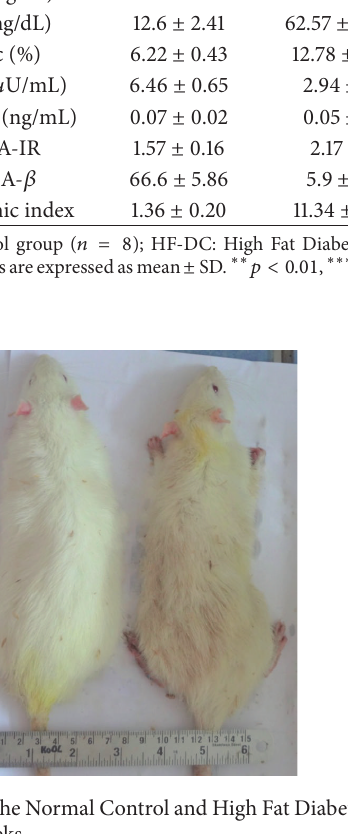
Figure 3: Time course changes in total cholesterol among experi- mental groups of NC ( 𝑛 = 8 ), HF-DC group ( 𝑛 = 7 ). Values are expressed as mean ± SD. ∗∗ 𝑝 < 0.01, ∗∗∗ 𝑝 < 0.001 , NC versus HF- DC.